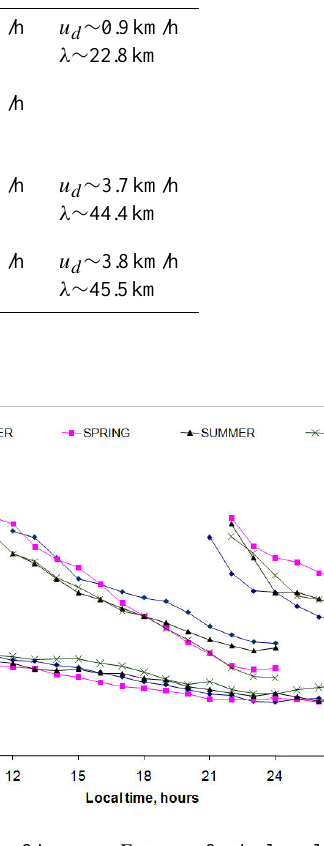
Fig. 8. Superposition of the mean E s traces for the low altitude diur- nal trace and upper altitude daytime and nighttime semidiurnal-like traces prevailing in the Arecibo observations for different